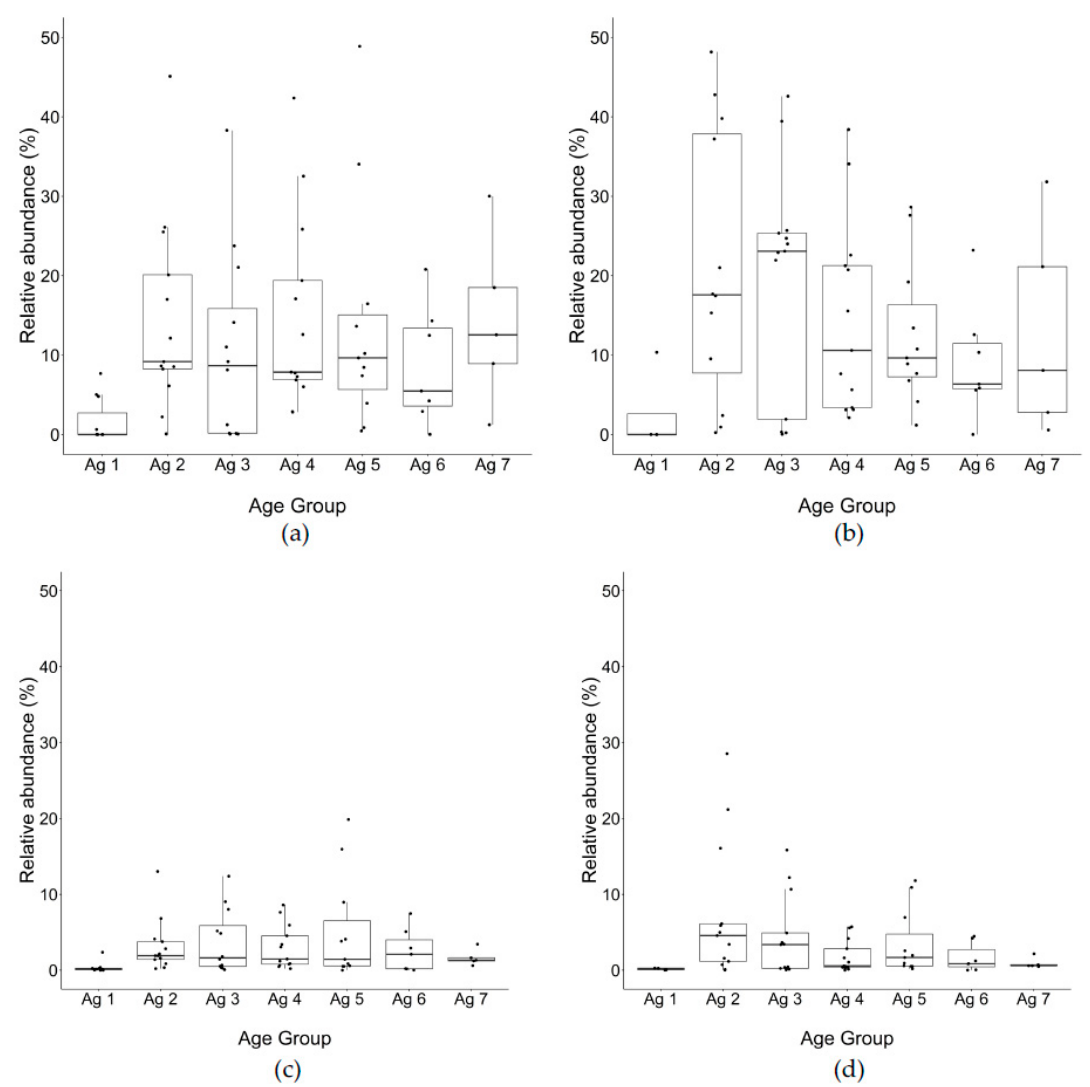
Figure 6. Relative abundance of ( a , b ) Weissella and ( c , d ) Streptococcus using OTU classification of 16S rRNA gene amplicon sequences for cheeses from 13 trials (% of total reads identified to genus level) (left): total DNA, (right): PMA-treated DNA. Ag 1: 0–1 m, Ag 2: 3–6 m, Ag 3: 7–10 m, Ag 4: 12–15 m, Ag 5: 18–20 m, Ag 6: 24, Ag 7: 30–32 m.